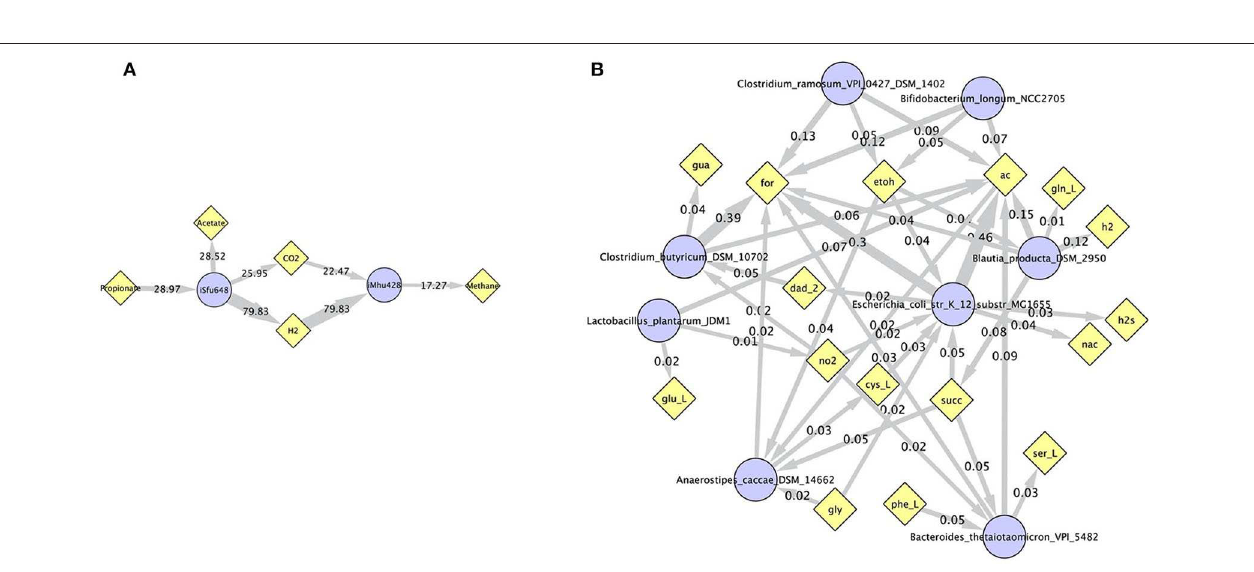
Frontiers in Bioengineering and Biotechnology |